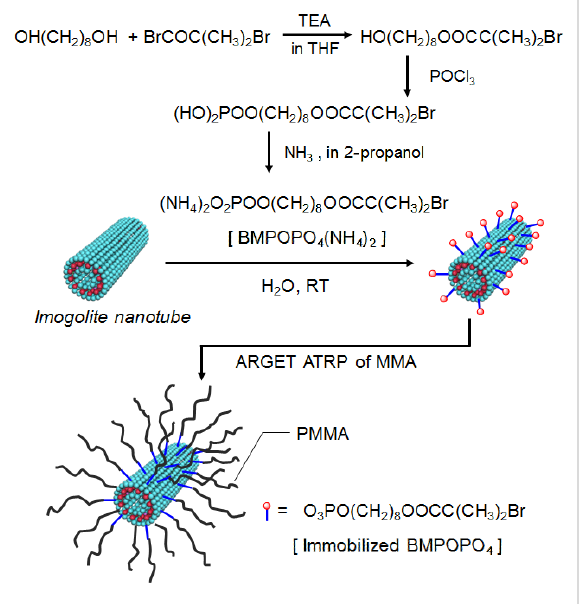
Figure 10: Schematic representation for the preparation of a PMMA grafted imogolite nanotubes. Reprinted with permission from W. Ma et